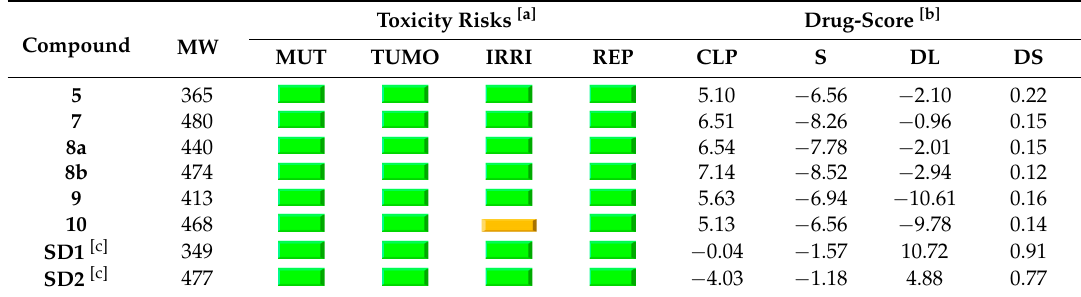
Table 4. Molinspiration calculations of compounds 5 , 8a , 8b , 9 , l0 and standard drugs SD1 , 2 .